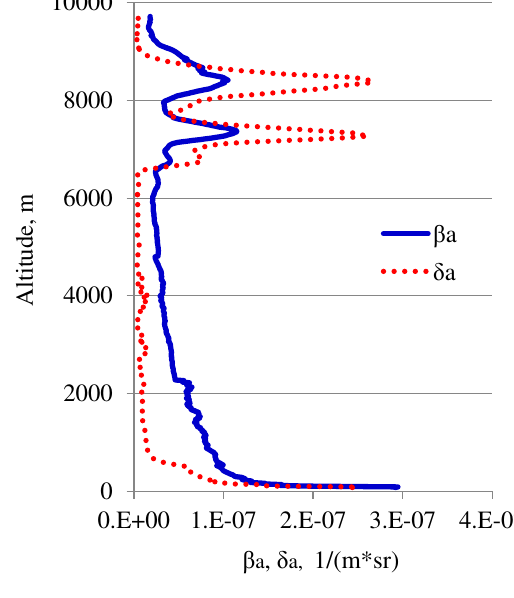
Figure 2 Vertical profile of the backscattering coefficient β a and its standard deviation δ a